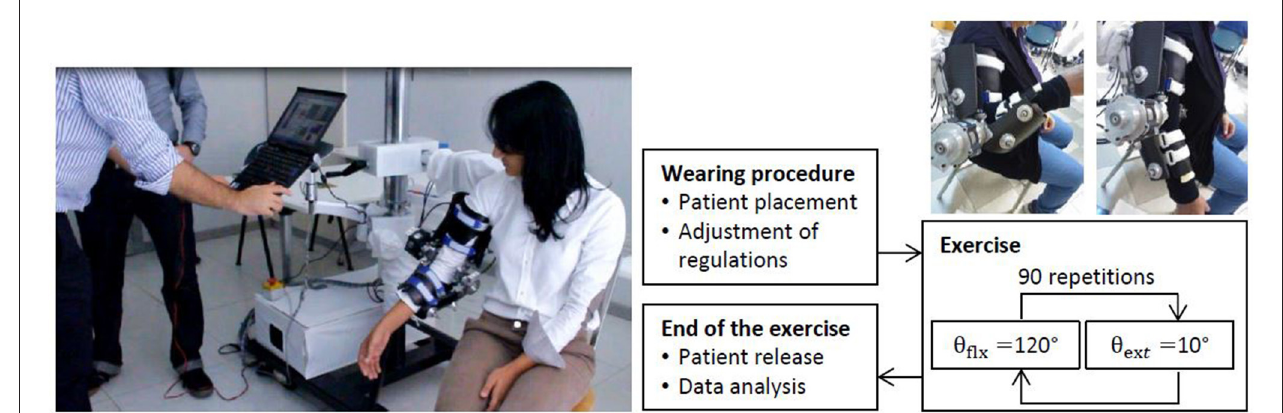
FIGURE 1 | Overview of the NEEM system in the clinical